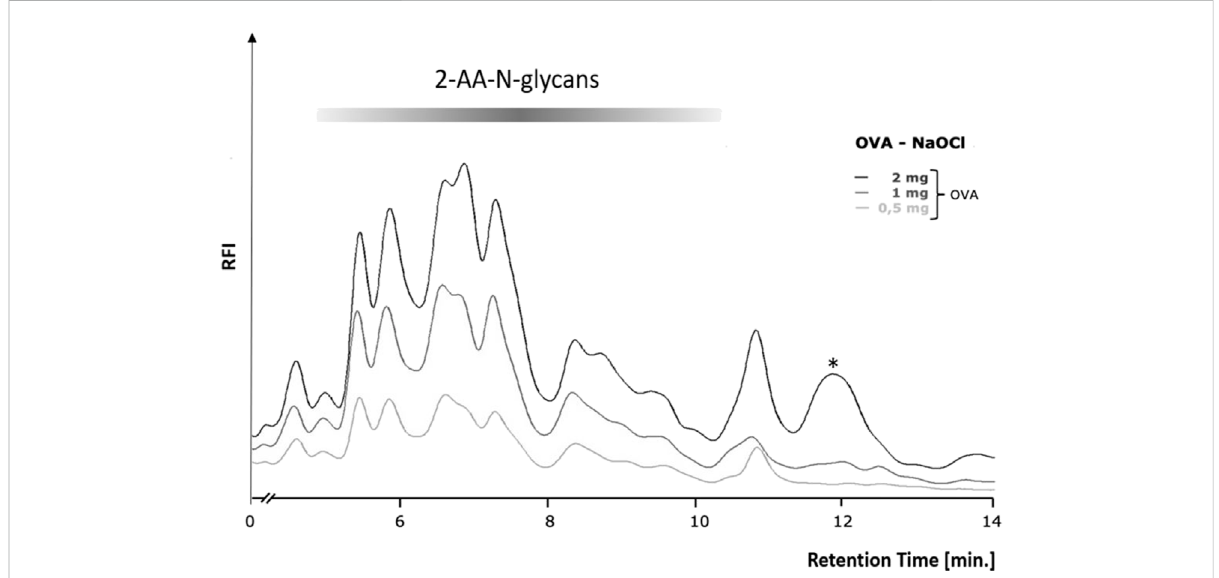
FIGURE 3 Glycoprotein concentration-dependent release of N-glycans by the hypochlorite method. Increasing amounts of chicken ovalbumin (OVA) from 0.5 – 2 mg yielded a similar RP-HPLC-FLD peak pro fi le but with increasing relative fl uorescence intensity (RFI) for the respective 2-AA-labeled N-glycans. At 2 mg ovalbumin, additional strong non-glycan artifact peaks (asterisks) emerged at retention times of 12 and 13.7 min.